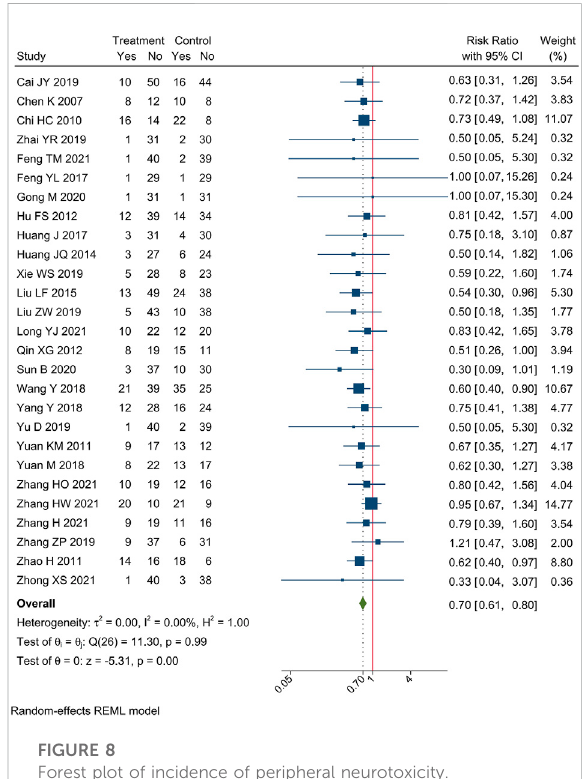
FIGURE 8 Forest plot of incidence of peripheral